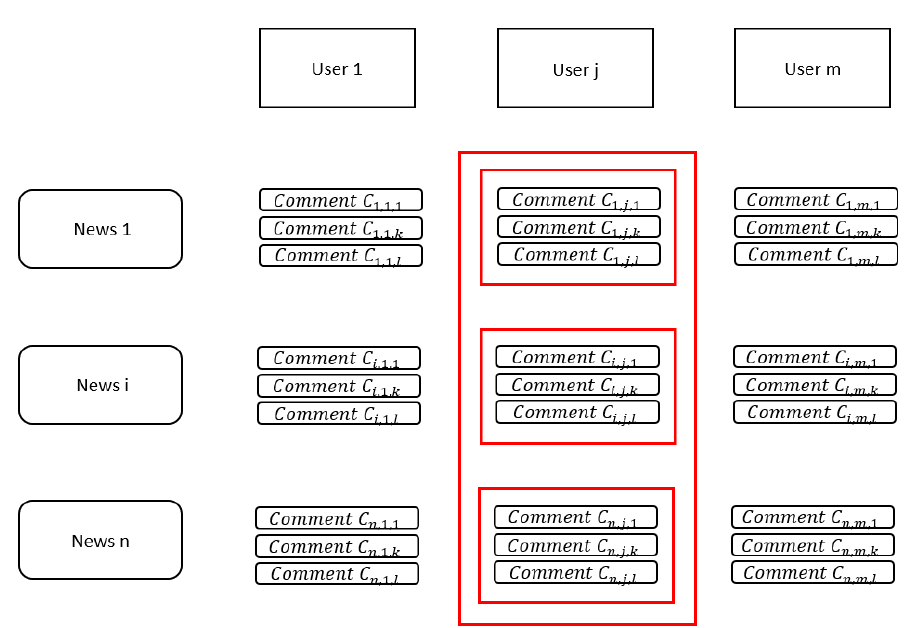
Figure 3. Method to evaluate how many similar comments each user writes.